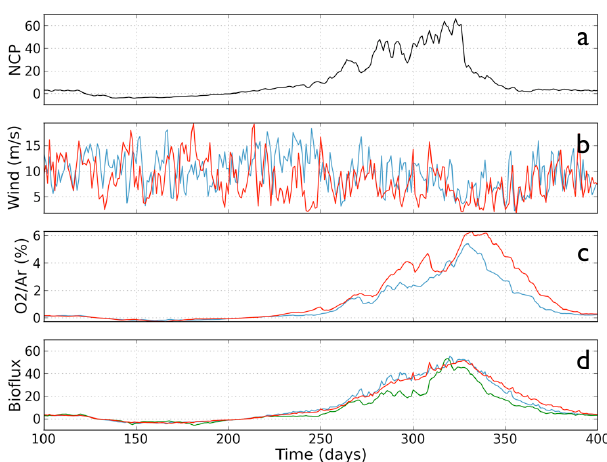
Saturday, April 21, 12 Figure 14. Panel (a) shows mixed-layer integrated NCP from the TOPAZ model at 61 . 5 ◦ S, 159 . 5 ◦ W over a 400-day period. Panel (b) shows two wind time series for the same time. The blue line represents the NCEP/CORE reanalysis winds from the same lo- cation as the model NCP data, and the red line represents Quickscat- satellite-derived winds from the same location. The two lines in panel (c) represent the resulting (cid:49) O 2 / Ar supersaturation from a box model simulation based on the time series in panels (a) and (b) . Panel (d) shows O 2 bioflux calculated from the time series in pan- els (b) and (c) . The red line is based on reanalysis winds and (cid:49) O 2 / Ar, the blue line is based on Quickscat winds and (cid:49) O 2 / Ar, and the green line is based on Quickscat winds and (cid:49) O 2 / Ar calcu- lated from reanalysis